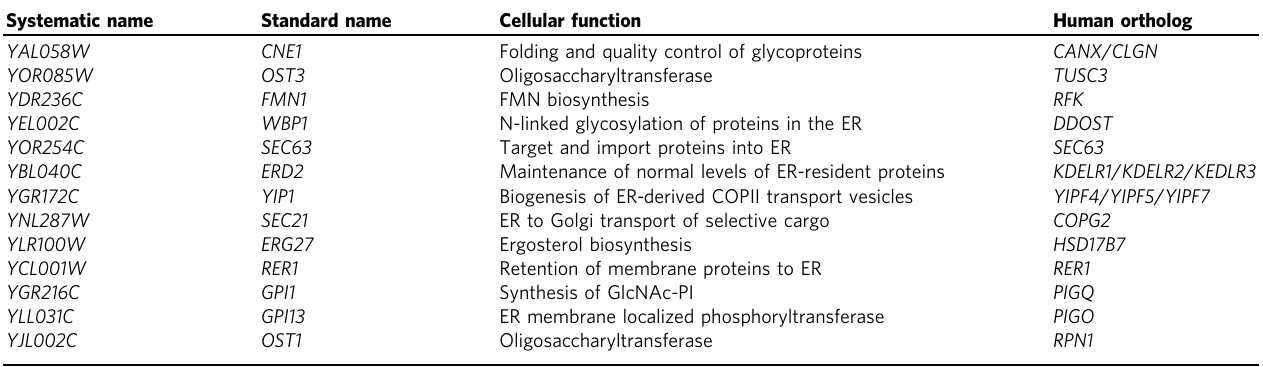
Table 1 Modi fi ers of A β 42 toxicity in protein secretion and degradation processes a